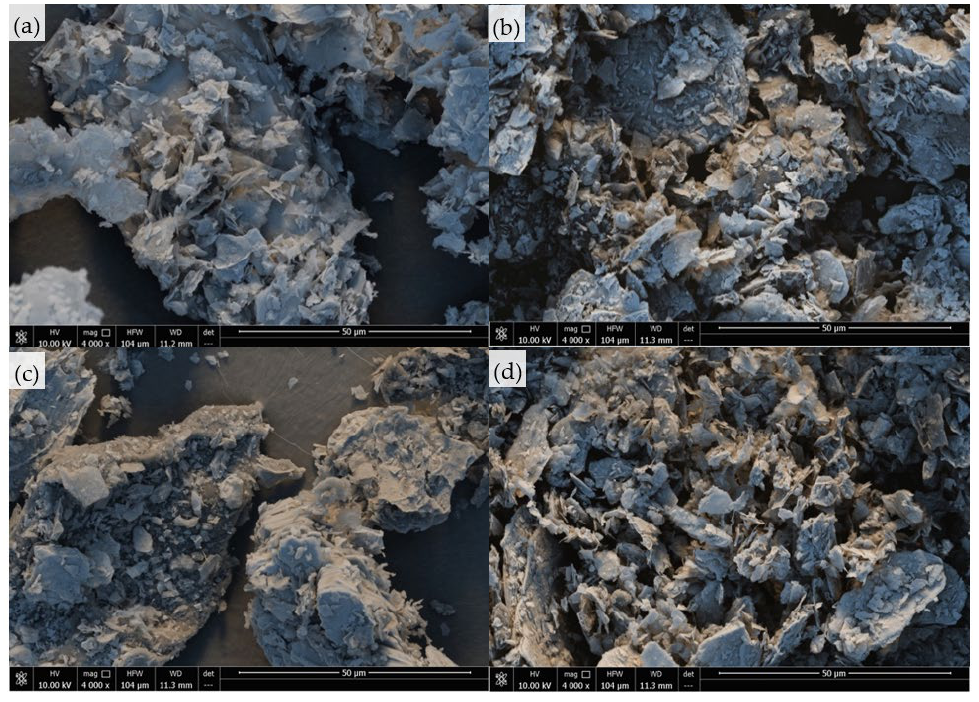
Figure 1. External morphology of ( a ) unmodified vermiculite filler, and vermiculite fillers modified with ( b ) casein, ( c ) chitosan, and ( d ) potato protein.